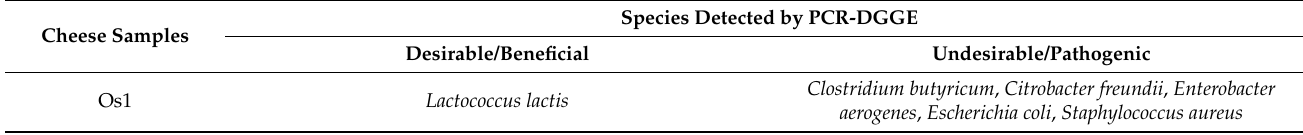
Table 3. Microbial diversity of studied cheeses assessed by